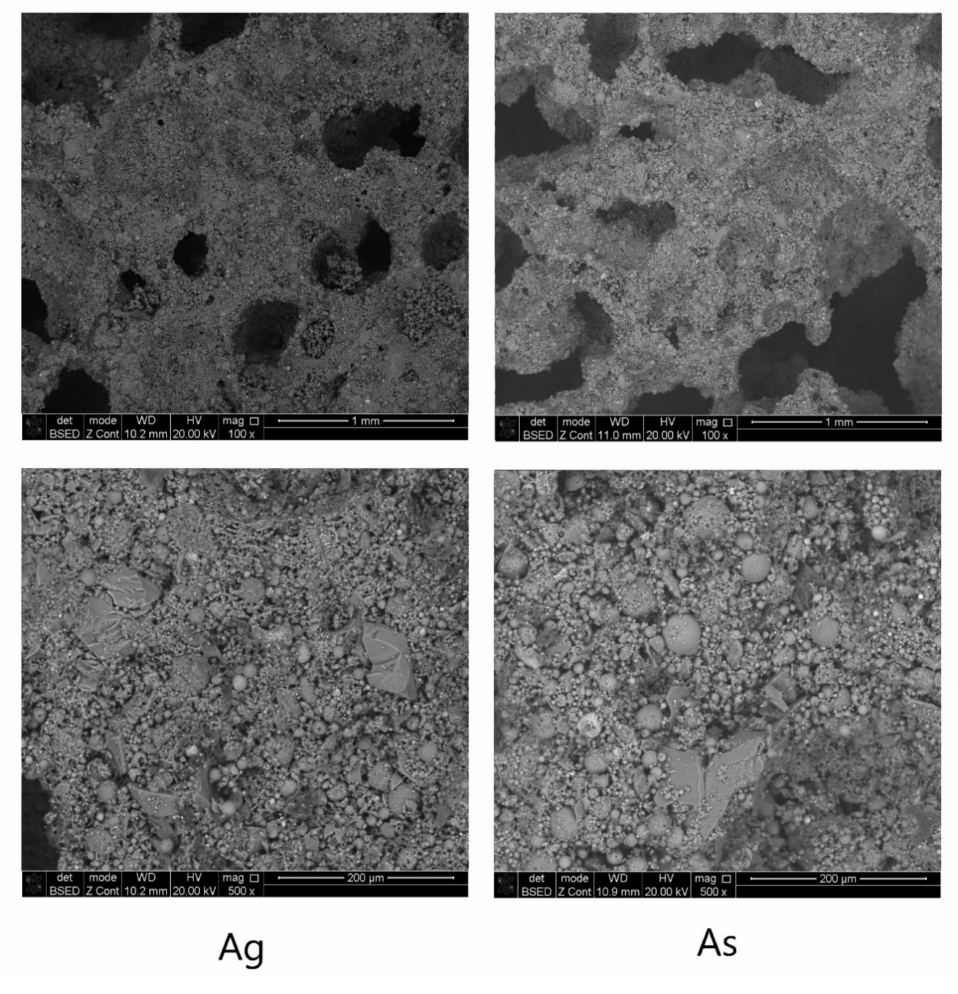
Figure 7. Microstructure of geopolymers. Table 5. Elemental composition of samples,